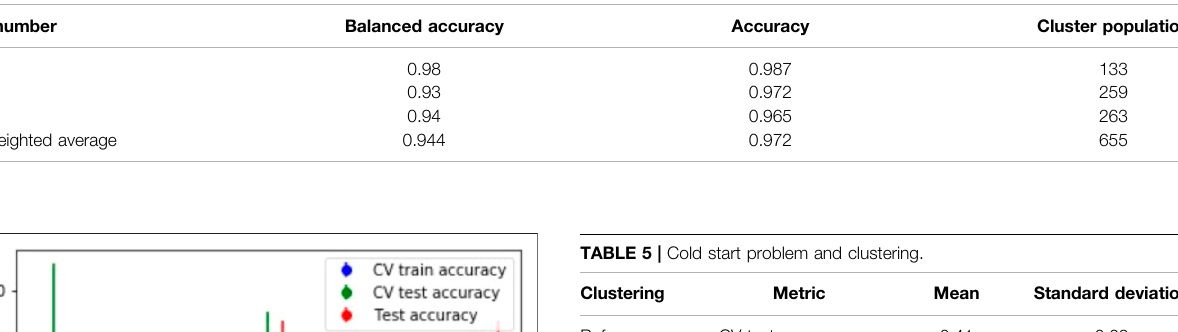
TABLE 4 | Weighted test accuracy after clustering.